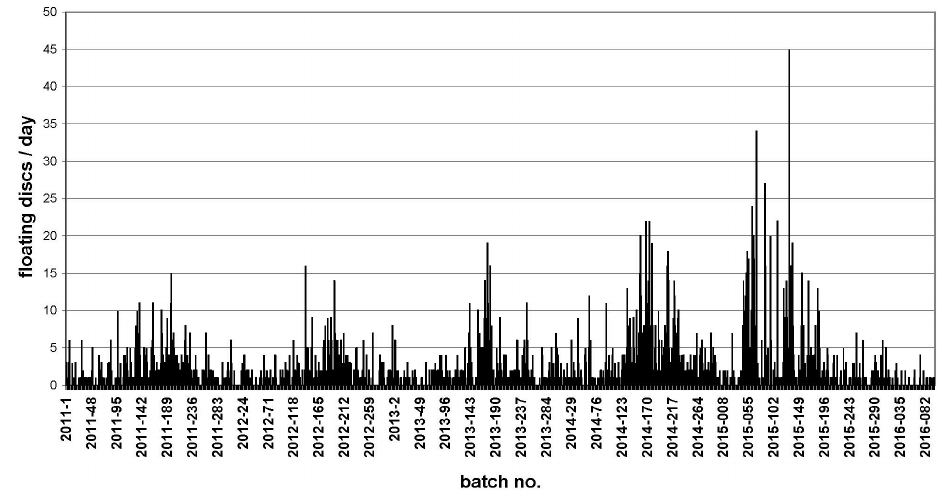
Figure 2. Course of “floating disc” signals over 5 years, from January 1 st 2011 (2011-1) until April 30 th 2016 (2016-098).